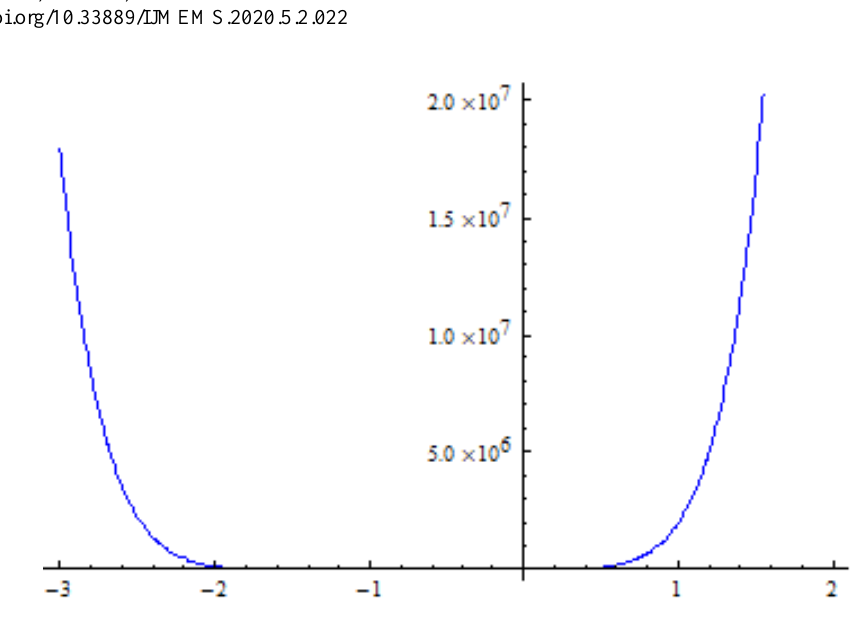
u of the equation (10) obtained by the nine-terms approximation solution Figure 1. The h -curve of ) 0 , 1 ( tt of the Homotopy analysis method Table 1. Absolute errors for u(x, t) obtained by the nine-terms approximate solution of the HAM for